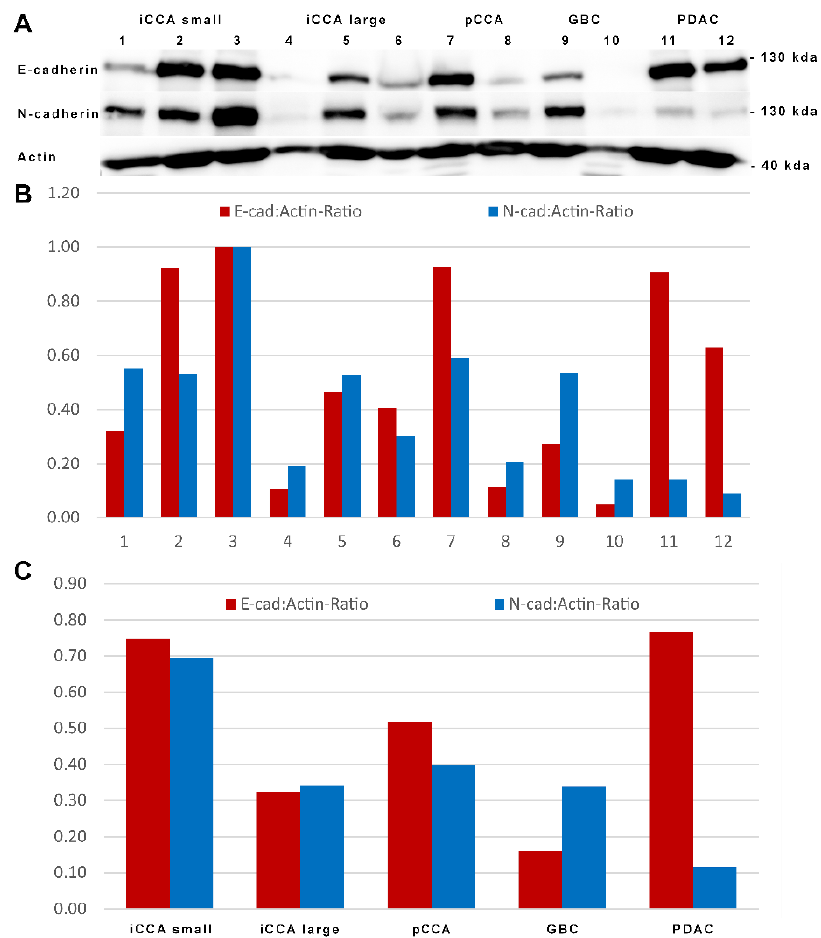
Figure 5. Semiquantitative immunoblot analysis shows equal levels of E- and N-cadherin in iCCA and pCCA, whereas PDAC displays predominant E-cadherin expression. ( A ): Immunoblot analysis of whole tissue lysates of iCCA (small and large duct iCCA (bands 1–3 and 4–6)), pCCA (bands 7 and 8), GBC (bands 9 and 10), and PDAC (bands 11 and 12) was probed with antibodies against E ‐ and N ‐ cadherin. Of note, whole tissue lysates were N ‐ cadherin ‐ positive in stromal cells and vessels. Equal amounts of protein were loaded and equilibrated with actin. Molecular mass markers are depicted on the right side. The uncropped Western blots are shown in Figure S4. Graphical representation of the pixel density analysis of the respective bands ( B ) and the respective tumor ( C ).